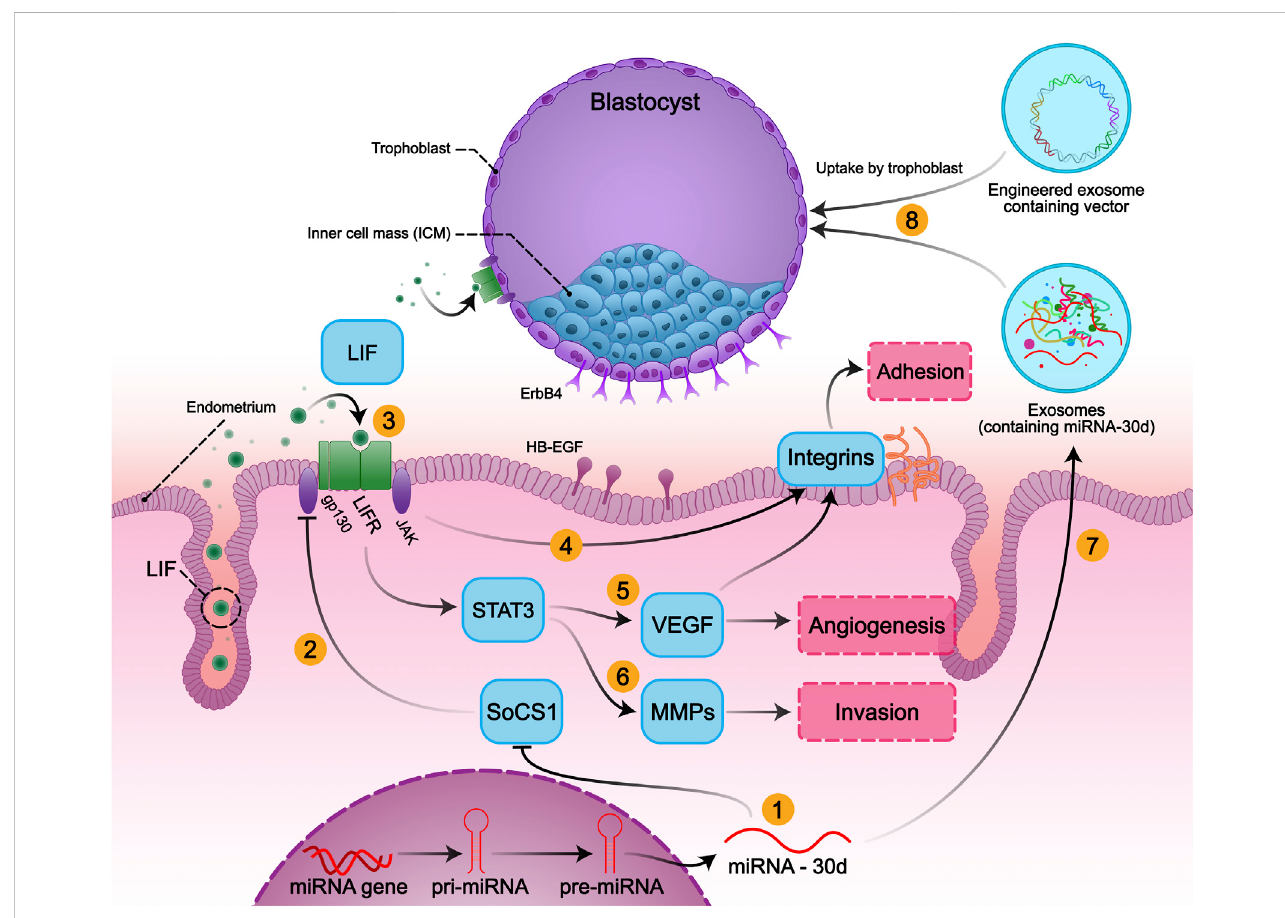
FIGURE 1 Embryo-Uterine molecular signaling in implantation and the role of miR-30d in embryo implantation: The implantation process involves three main steps: adhesion, invasion, and angiogenesis, which contribute to successful implantation. Expression of mir-30d as a modi fi er of the embryo implantation modi fi es its transcriptome, resulting in overexpression of genes involved in embryonic adhesion, invasion, angiogenesis, and endometrial receptivity. (1) MiR- 30d promotes theactivation ofthe LIF-induced STAT3 pathway, possibly via downregulating SOCS1in the embryo and endometrium. (2) SOCS1 inhibits the LIF/JAK/STAT3 signaling by inhibiting the activation of JAK. (3) LIF activates gp130/STAT3 signals via binding to LIFR and gp130 heterodimer both in endometrium and embryo. Activation of STAT3 (4) induces adhesion by increasing the expression of integrin alpha-7, integrin beta-3, and also (5) promotes angiogenesis by inducing VEGF expression and (6) invasiveness of trophoblastic cells by activating the transcription of MMPs. (7) Human endometrium secretes miR-30d, (8) then exosomal has-miR-30d is taken up by the trophoblasts and delivered to the embryo fl uid (EF) to modify the embryonic